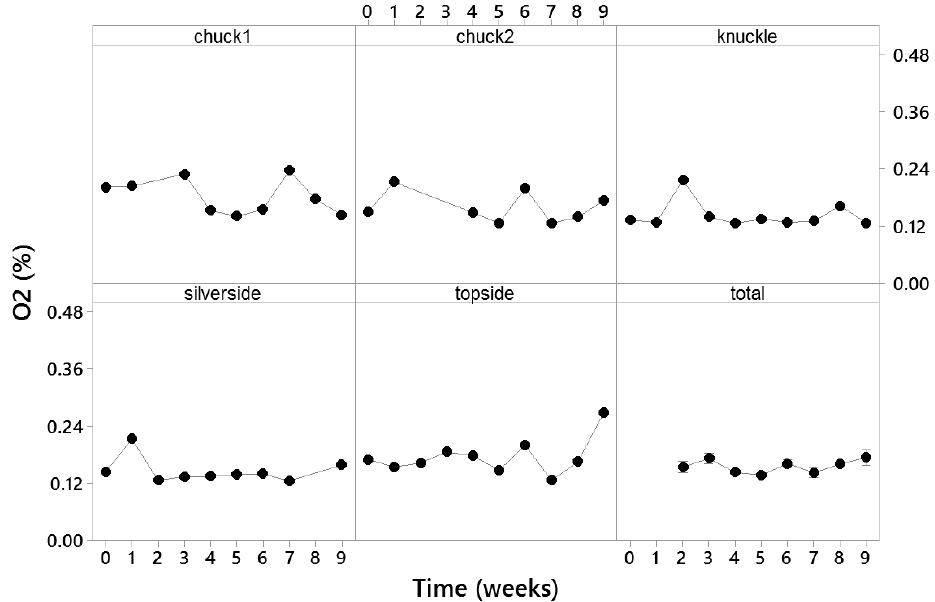
Figure 4. Variation in the residual O 2 concentration in the VP meat during storage for up to nine weeks at 1 ± 0.5 ◦ C. The data represent the mean value of 15 measurements (three replicates for each of the five samples at each timepoint), and error bars represent thestandard error.